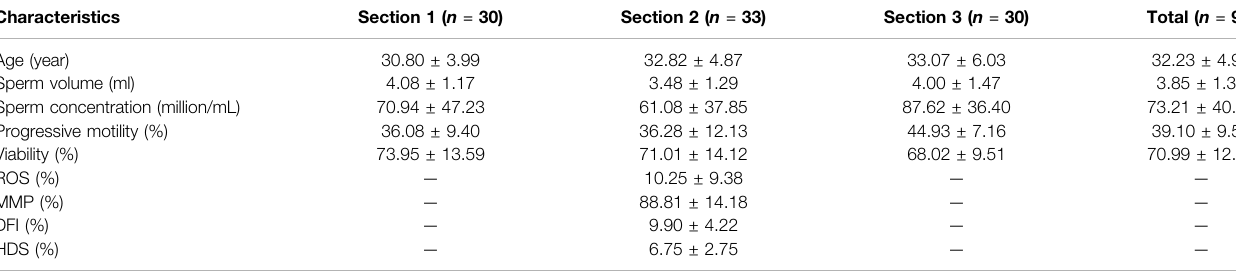
TABLE 1 | Characteristics and sperm parameters in patients from sections 1, 2 and 3.